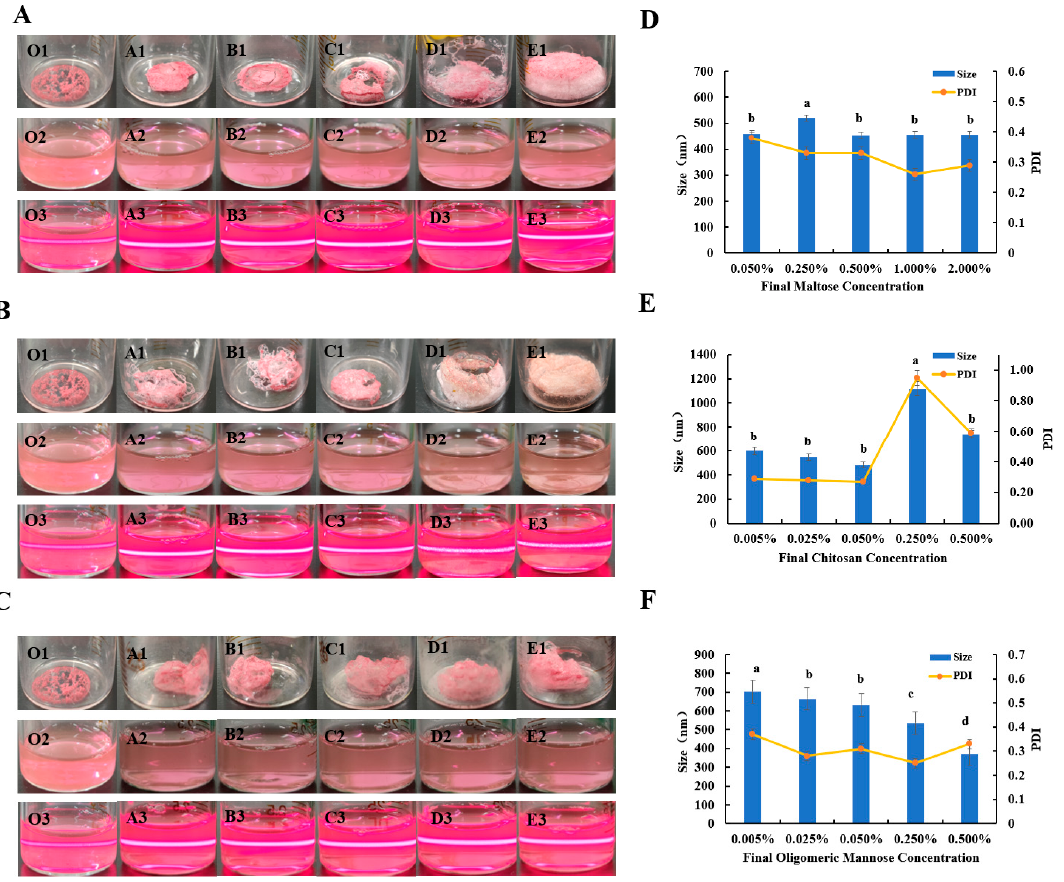
Figure 3. Effect of different concentrations of sugars (oligomeric mannose, chitosan, maltose) on ABC-NPs lyophilized powder: the appearance of ABC-NPs (lyophilized powder, re-soluble state, and Tyndall effect) ( A – C ) and particle size ( D – F ).